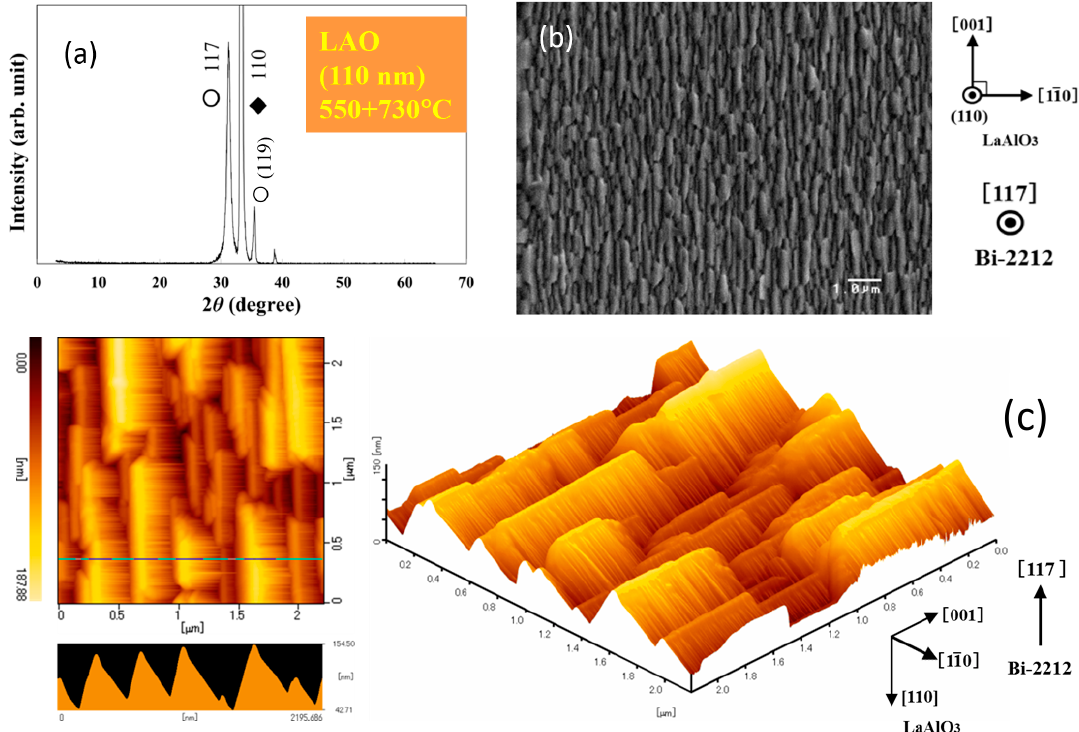
Figure 5. Non c ‐ axis Bi ‐ 2212 thin film on flat (110) LaAlO 3 substrate obtained by two ‐ temperature growth: ( a ) XRD pattern, ( b ) SEM image and ( c ) AFM 2D and 3D images and roughness profile (RMS = 33.2 nm). Phases are: ○ Bi ‐ 2212, ♦ substrate.